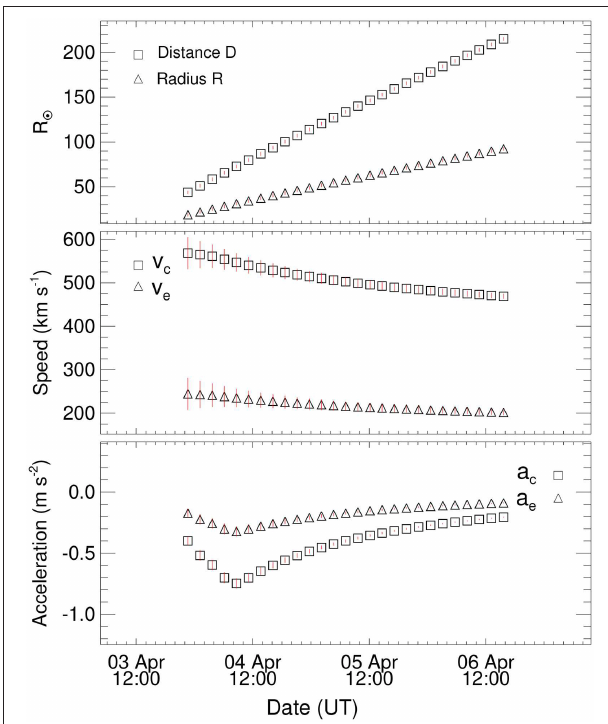
FIGURE 7 | The kinematics of 3 April 2010 CME as obtained by using the drag based model (DBM) is shown. Top panel shows the estimated heliocentric distances ( D ) of the center of flux rope CME and its radius ( R ). The first-order derivative of D and R as the propagation speed ( v c ) and expansion speed ( v e ), respectively, are shown in the middle panel. The bottom panel shows the propagation acceleration ( a c ) and expansion acceleration ( a e ) as the first-order derivative of v c and v e , respectively. The vertical lines at each data point show the error bars. The errors are derived from the arbitrary assumption of the uncertainties of 2 R ⊙ in the estimates of D